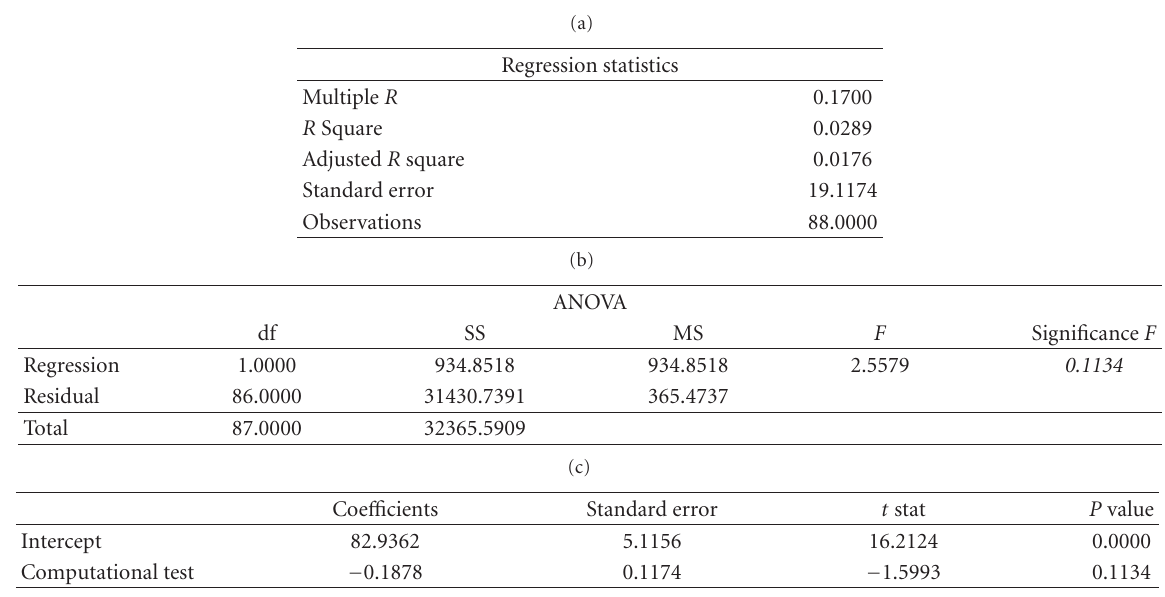
Table 4: Results interpretation versus computational test.